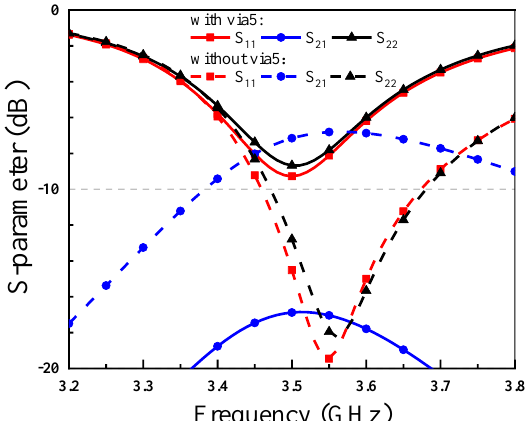
Figure 5. ( a ) Current model diagram when Ant1 is excited without Via5. ( b ) Current model diagram when Ant1 is excited with Via5.